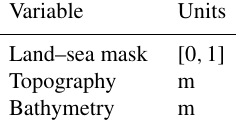
Table A3. Boundary